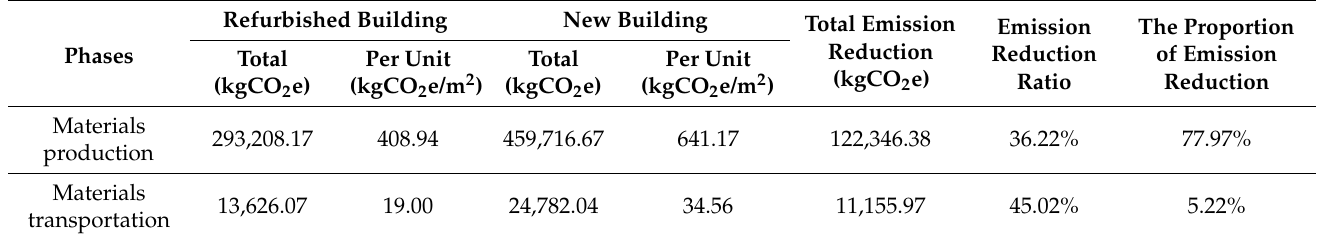
Table 9. Whole life cycle carbon emissions of refurbished building and new